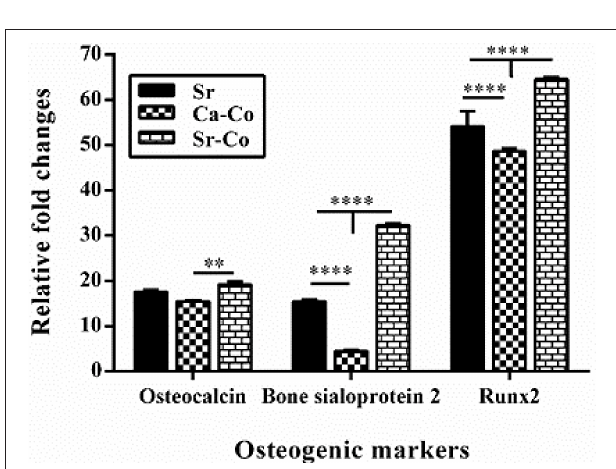
FIGURE 5 | The graph showing the amounts of ALP produced by iPSCs after culturing onto the glass samples. * p < 0.05, ** p < 0.01, *** p < 0.001, and **** p < 0.0001.